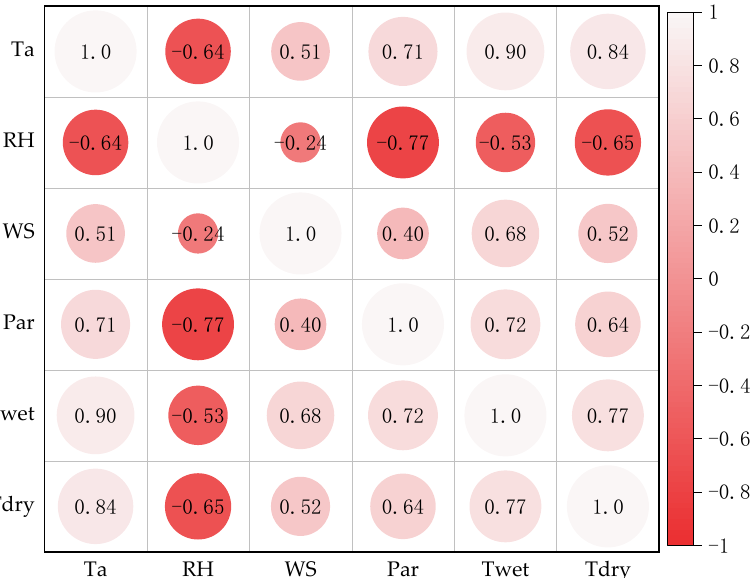
Figure 6. Correlations between climatic characteristics and the canopy temperature of two experi- ments.